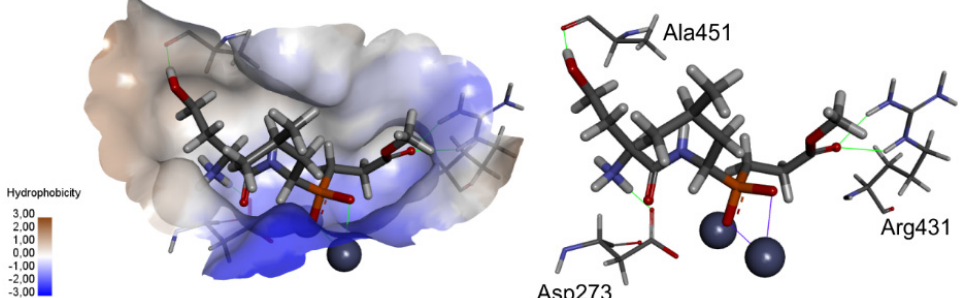
Figure 7. Modeled binding mode of 3 -SS isomer in the active center of bovine leucyl aminopeptidase (PDB: 1LCP). Amino acid residues of the inhibitor and enzyme are shown as sticks, while the zinc ions are shown as a gray sphere. Hydrogen bonds are shown as thin green lines, metal ion—phosphinic moiety interaction is shown as a thin blue line, while the surface of the active site is colored according to hydrophobicity.